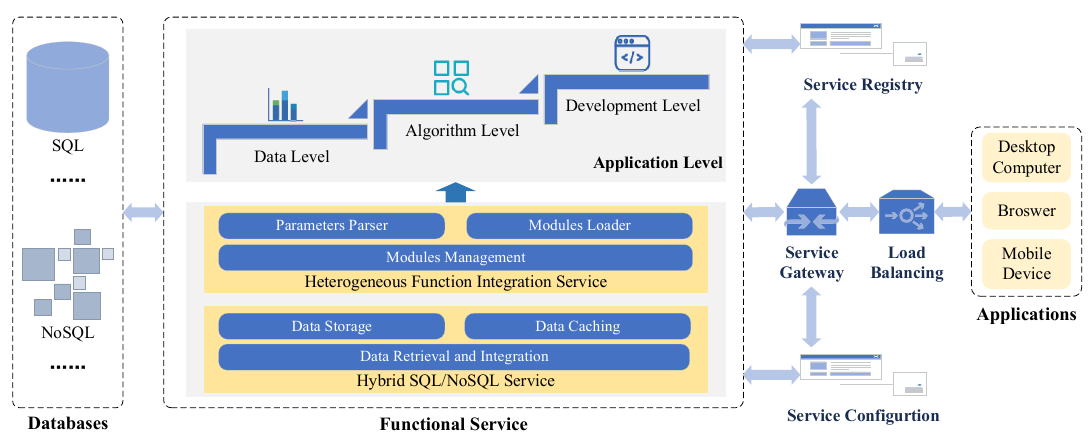
Figure 1. Platform architecture and orientation. All functional services are built on top of databases, and provide di ff erent levels of applications for di ff erent requirements and